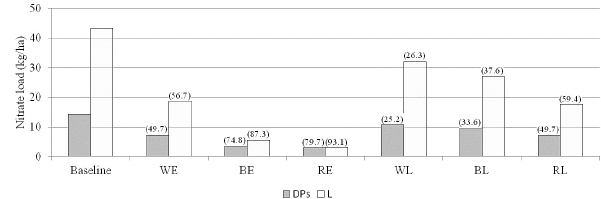
Figure 8. The 8-year average nitrate leaching and delivery to wa- terways during winter fallow assessed at the field scale under multi- ple cover crop scenarios. Note: DPs (Direct pathways) refers to the amount of nitrate transported from agricultural fields (HRUs) to wa- terways by surface flow, lateral flow, and groundwater; L is nitrate leaching to groundwater. The numeric value in parentheses, (), indi- cates reduction rate (RR). As the growth period of winter cover crop covers from October to March, results presented here were based on the eight years of simulation from October 1992 to March